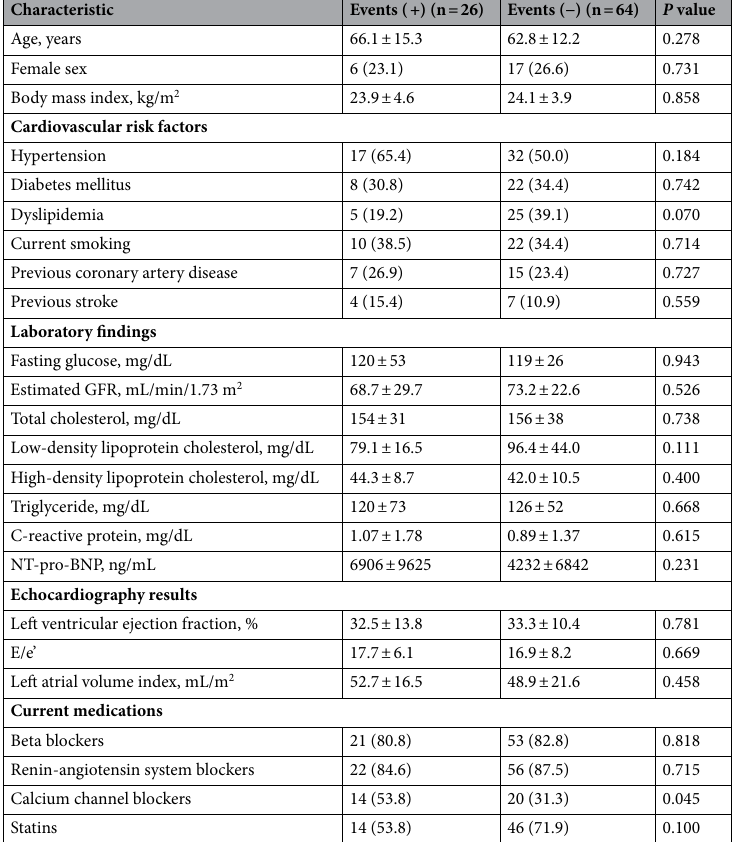
Table 1. Clinical characteristics according to clinical events. Numbers are expressed as mean ± SD or n (%). GFR glomerular filtration rate; NT-pro-BNP N-terminal-pro-brain natriuretic